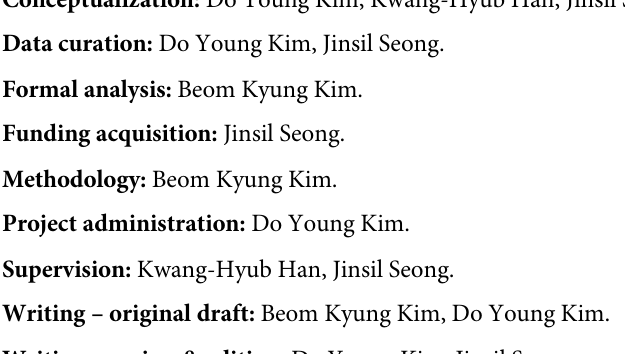
S1 Fig. The detailed first-line treatment modalities according to BCLC stage in the E-Cohort (A) and L-Cohort (B). S2 Fig. Kaplan-Meier analysis of overall survival according to treatment modalities (trans- hepatic arterial therapy vs. other LRTs) among BCLC stage B patients. S3 Fig. Kaplan-Meier analysis of overall survival according to treatment modalities (sora- fenib vs. LRTs) among BCLC stage C patients with Child-Pugh class A since